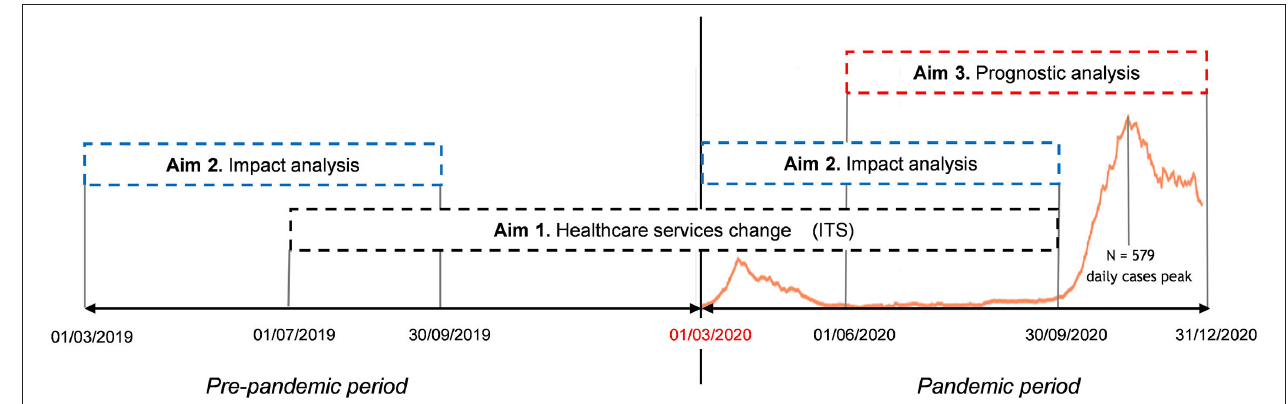
FIGURE 1 | The study analysis plan of the study is according to the three aims. Aim 1—Healthcare services change: interrupted time-series (ITS) design applied to the four cohorts (PD, AP, VP, and controls) from July 1, 2019, to September 30, 2020. Aim 2—Impact analysis: historical cohort design applied to the three cohorts comparing the period March to September 2020 with the same period of 2019. Aim 3—Prognostic analysis: historical cohort design applied to the PD cohort from June 1, 2020, to December 31, 2020. The absolute number of SARS-CoV-2 infected people is reported in orange color in the time